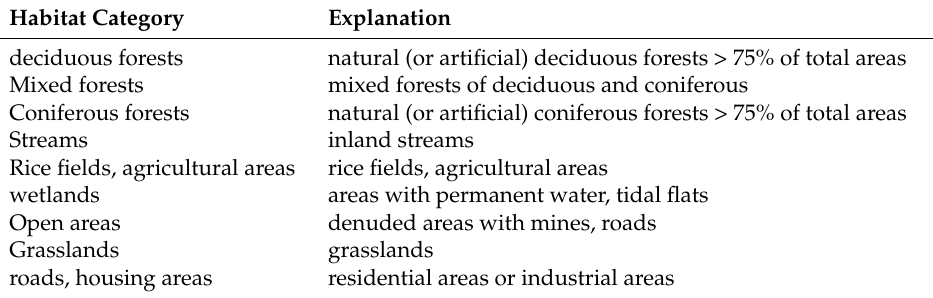
Table A1. The category of habitat pattern based on the Land Cover